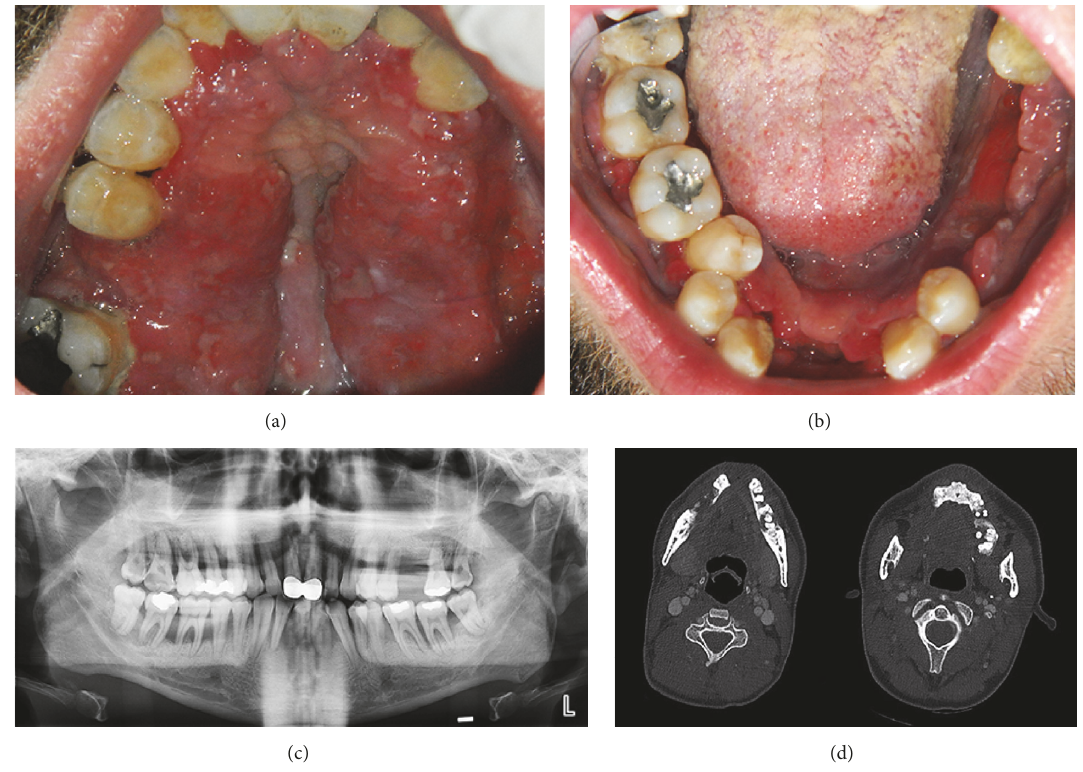
Figure 1: (a) Intraoral view of the patient after extraction of teeth with severe mobility, prior to initiation of chemotherapy. Extensive gingival lesions are observed on the palatal surface of the maxilla. (b) Intraoral view of the patient after extraction of teeth with severe mobility, prior to initiation of chemotherapy. Diffuse, erythematous, and ulcerated gingival hyperplasia is observed in the mandible. (c) Panoramic radiograph of the patient at initial presentation. Generalized alveolar bone loss is observed. (d) Axial sections of the computed tomography scan obtained at initial presentation. Diffuse involvement of both maxilla and the mandible is